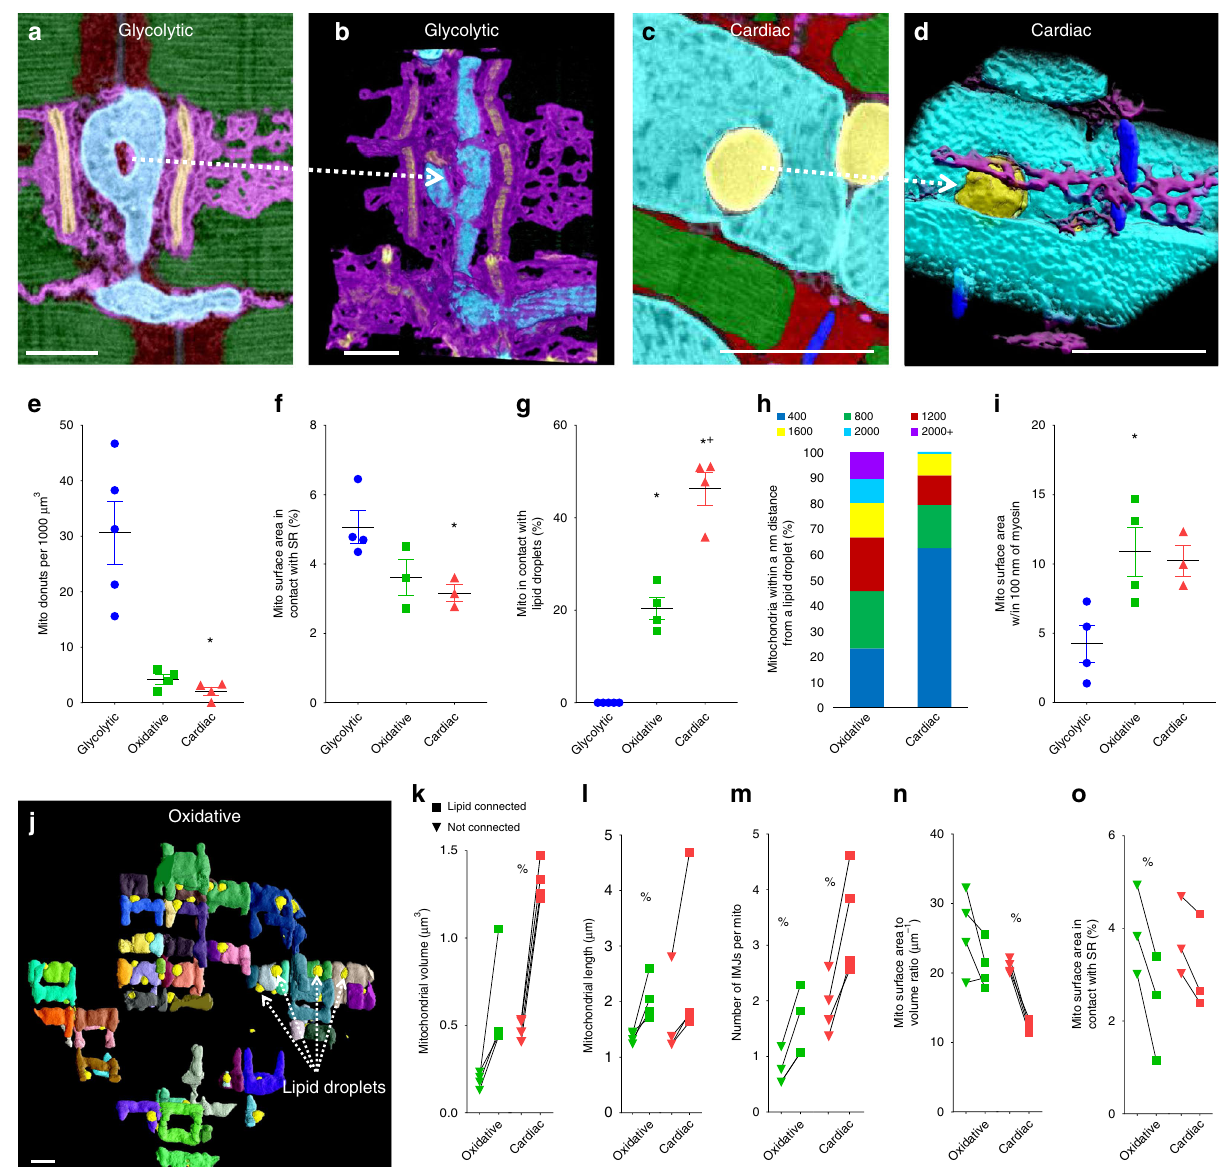
Fig. 4 Individual mitochondria play specialized roles within the network. a Overlay of segmented and raw single image from glycolytic muscle FIB-SEM volume showing a mitochondrion (cyan) with a donut hole partially fi lled with sarcoplasmic reticulum (magenta). T-tubules – orange, z-disks – blue, I-band – red, A-band – green. b 3D rendering of the data in a showing only mitochondria, sarcoplasmic reticulum and t-tubules. c Overlay of segmented and raw single image from cardiac muscle FIB-SEM volume showing a mitochondrion with a donut hole completely fi lled with a lipid droplet (yellow). d 3D rendering of the data in c showing only mitochondria, sarcoplasmic reticulum, and lipid droplets. e Mitochondrial donuts per 1000 µ m 3 muscle volume. glycolytic, n = 144 donuts, 5 datasets; oxidative, n = 26 donuts, 4 datasets; cardiac, n = 26 donuts, 4 datasets. f Mitochondrial surface area in contact with sarcoplasmic reticulum. glycolytic, n = 637 mitochondria, 4 datasets; oxidative, n = 1488 mitochondria, 3 datasets; cardiac, n = 1019 mitochondria, 3 datasets. g Percentage of mitochondria in contact with lipid droplets. glycolytic, n = 720 mitochondria, 5 datasets; oxidative, n = 2410 mitochondria, 4 datasets; cardiac, n = 1462 mitochondria, 4 datasets. h Mitochondria within given distance from a lipid droplet. i Percentage of mitochondrial surface area within 100 nm of myosin. n = 637 mitochondria, 4 datasets; oxidative, n = 2410 mitochondria, 4 datasets; cardiac, n = 1019 mitochondria, 3 datasets. j 3D rendering of lipid-connected mitochondria in oxidative muscle. Mitochondria – various colors, lipid droplets – yellow. k – n Mitochondrial volumes (k), surface area-to-volume ratios (l), lengths (m), and surface area in contact with sarcoplasmic reticulum (n) for lipid droplet-connected and non-connected mitochondria. oxidative, n = 2410 mitochondria, 4 datasets; cardiac, n = 1462 mitochondria, 4 datasets. Points are means for each dataset. Squares- lipid droplet connected, triangles – non-lipid droplet connected. Lines between points indicate paired values from within single dataset. Bars represent muscle type overall mean ± SE. *Signi fi cantly different from glycolytic, + signi fi cantly different from oxidative, % signi fi cantly different from lipid-connected. Signi fi cance determined as p < 0.05 from one way ANOVA with Tukey ’ s HSD (variances not different) or Dunn ’ s multiple comparisons (variances different) post hoc tests for fi ber type differences, and for a paired t -test (normal distribution) or Wilcoxon signed rank test (not normal distribution) for lipid connected analyses. Scale bars – 1 µ